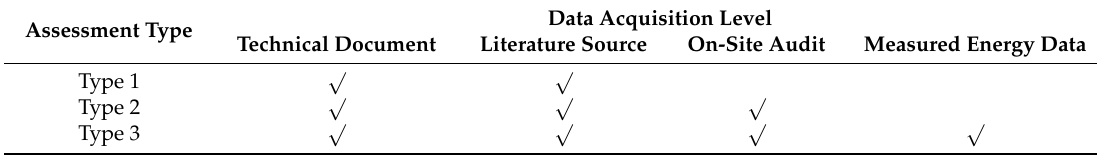
Table 3. Classification of assessment methods by data acquisition